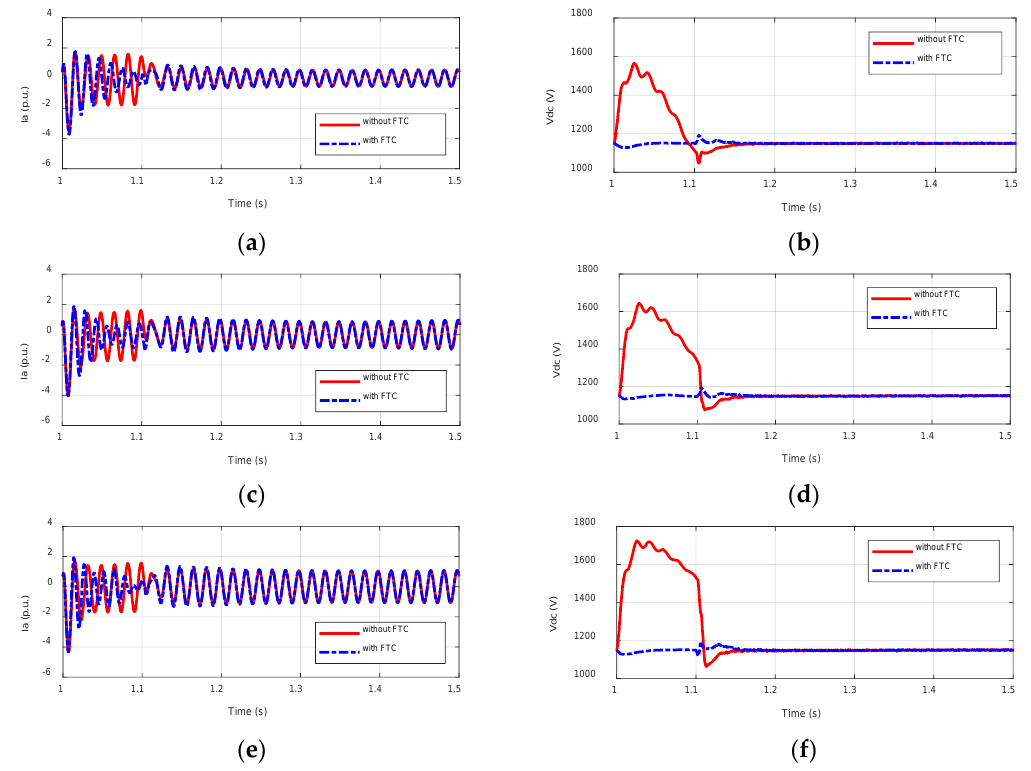
Figure 3. Line current and DC voltage (with/without FTC) for comparison results during low wind speed. ( a ) Line current at low wind speed; ( b ) DC voltage at low wind speed; ( c ) Line current at rated wind speed; ( d ) DC voltage at rated wind speed; ( e ) Line current at high wind speed; ( f ) DC voltage at high wind speed. Table 1. DC voltage overshoot under short-circuit and various wind speed ranges. Wind Speed (Category)